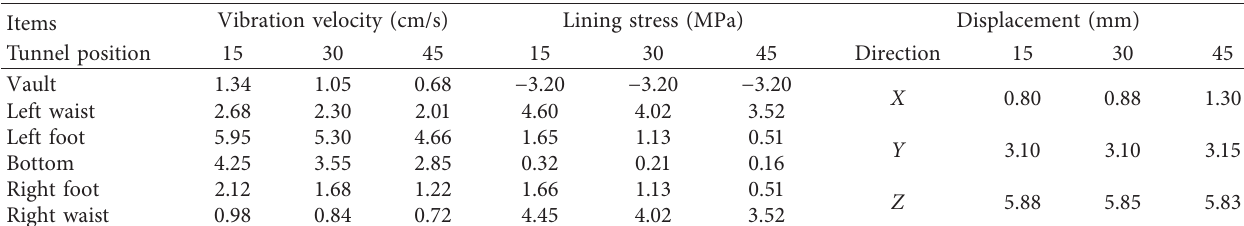
Table 6: The dynamic response of the existing tunnel to blasting under different cross angle conditions.